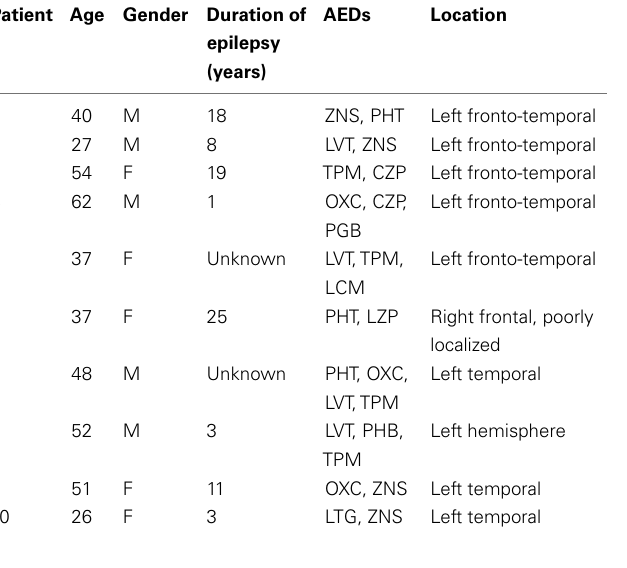
Table 1 | Epidemiology and clinical characteristics of the epilepsy patients.